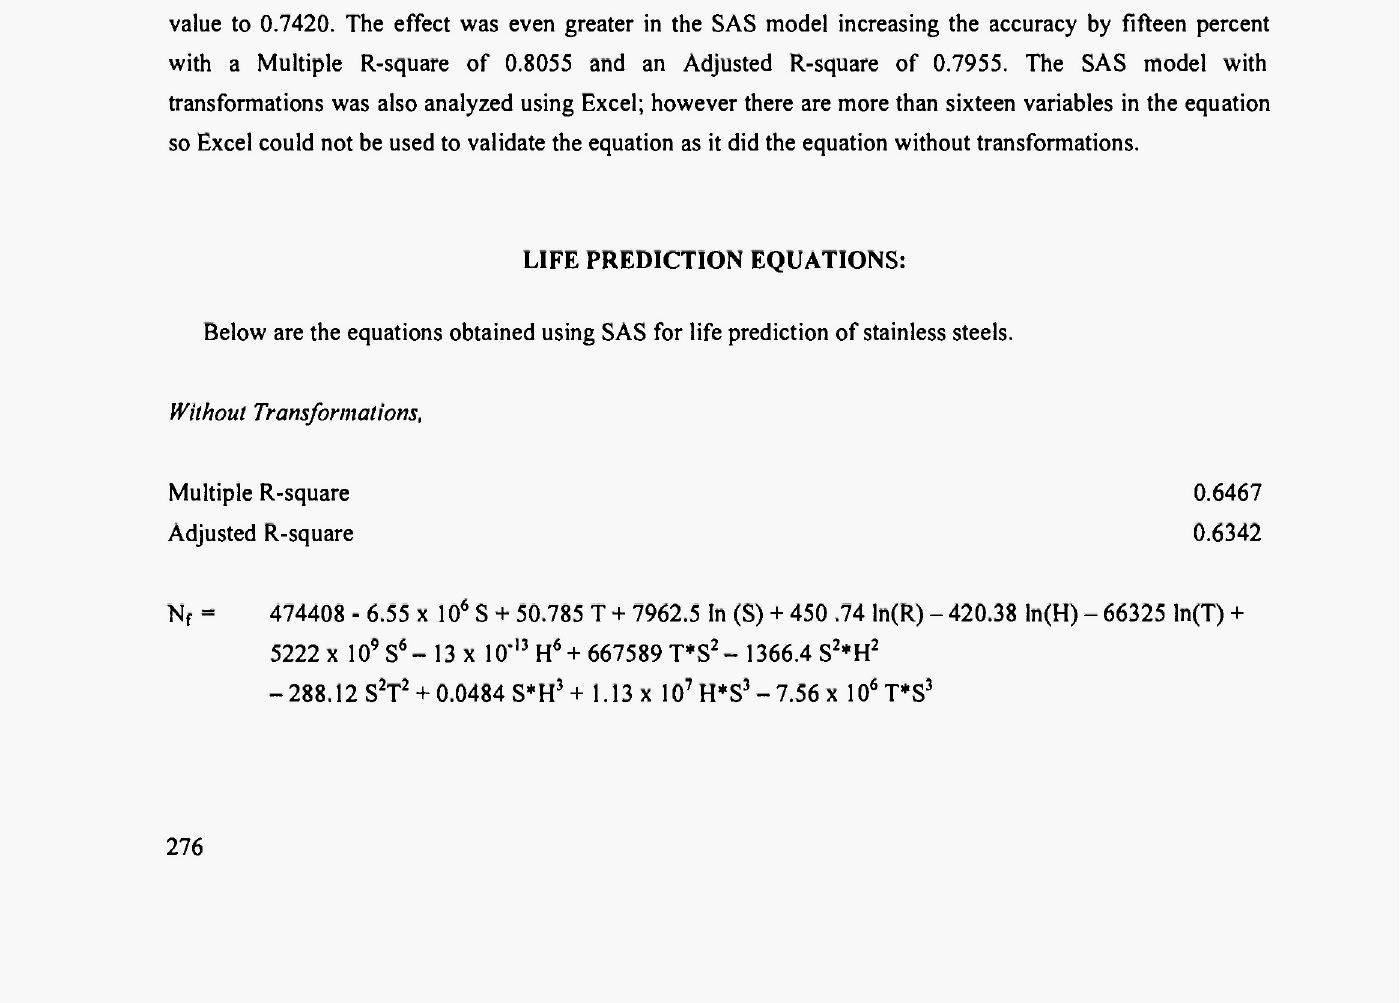
LIFE PREDICTION EQUATIONS: Below are the equations obtained using SAS for life prediction of stainless steels.